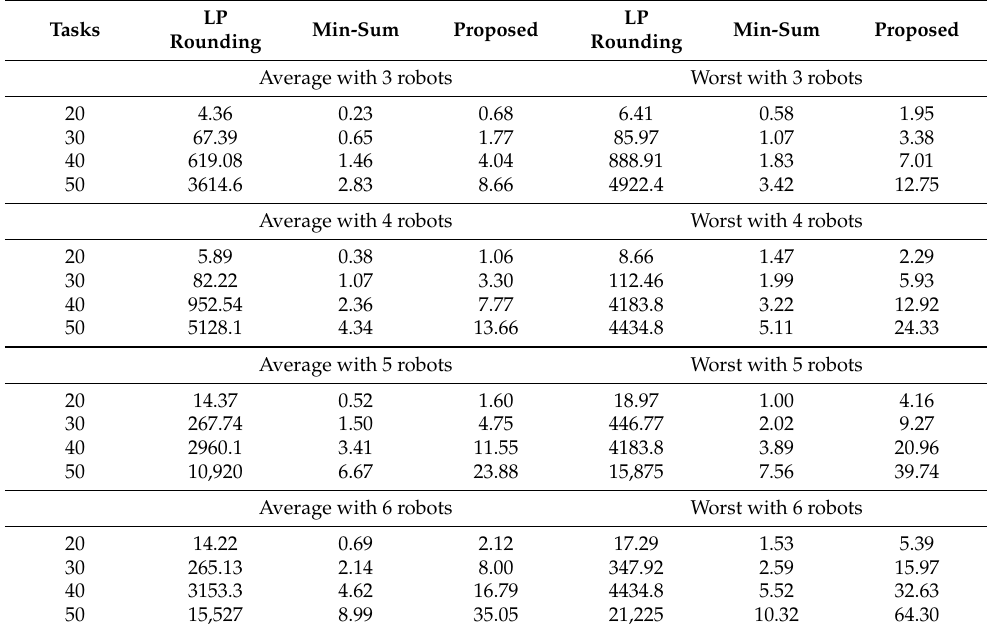
Table 1. Computation time in